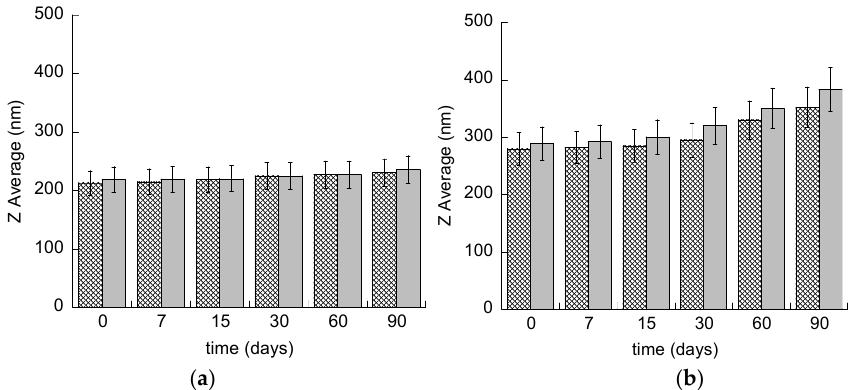
Figure 4. Mean diameter variation for ETHO ( a ) and ETHO-POL ( b ) unloaded (crisscross pattern) or CA loaded (grey pattern). Diameters have been measured by PCS during time, up to three months from production and expressed as Z average. Data are the mean of three determinations on different samples.